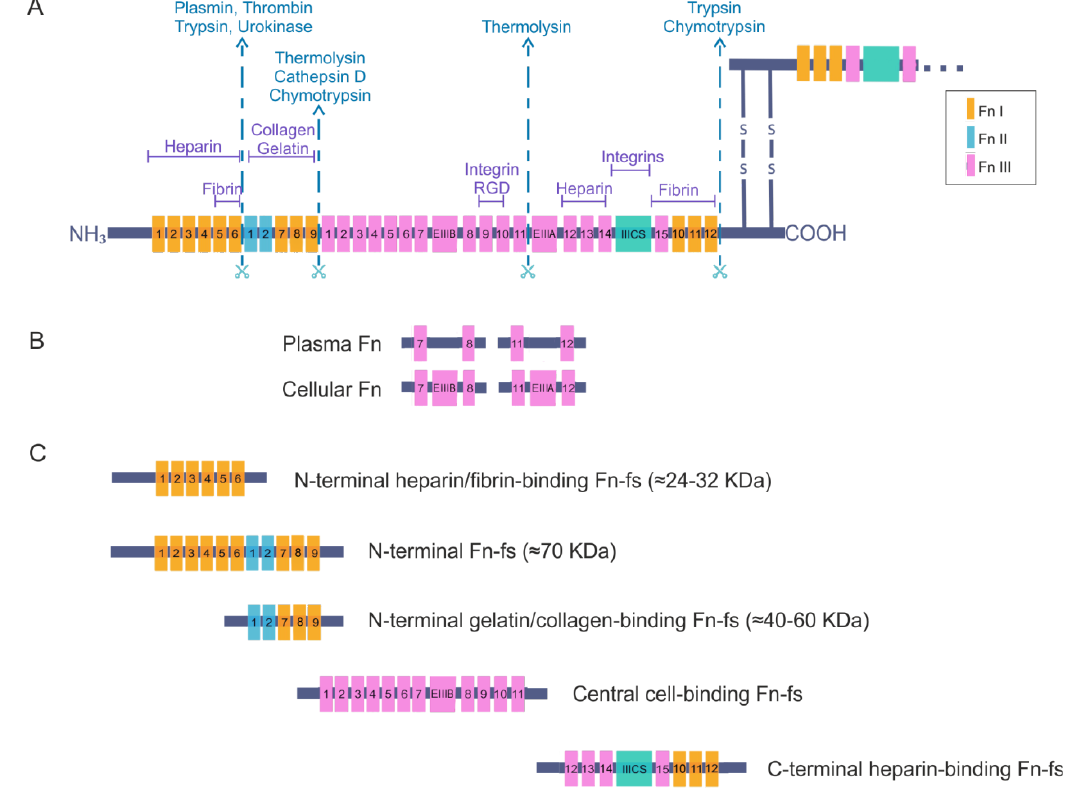
Figure 1. Fibronectin (Fn) and Fn fragments (Fn-fs) primary structure. ( A ) the schematic shows a representation of an Fn dimer and its interactions with different cell – surface receptors or other extracellular matrix (ECM) components such as heparin, collagen, and proteoglycans. Twelve Fn type I (FnI), two Fn type II (FnII) and fifteen constitutively expressed and two alternatively spliced Fn type III (FnIII) are indicated. The extra domains A and B (EIIIA and EIIIB) and the segment connecting two other FnIII repeats called the type III connecting segment (IIICS) or V domain are also shown. The scissors symbolize protease-sensitive regions of Fn and corresponding enzymes most commonly responsible for cleavage at these regions; ( B ) structural differences between plasma Fn and cellular Fn are shown; ( C ) the figure shows the different fragments of Fn and the structural domains that remain in each of them after breakage with proteolytic enzymes, adapted from [9,15 – 17].